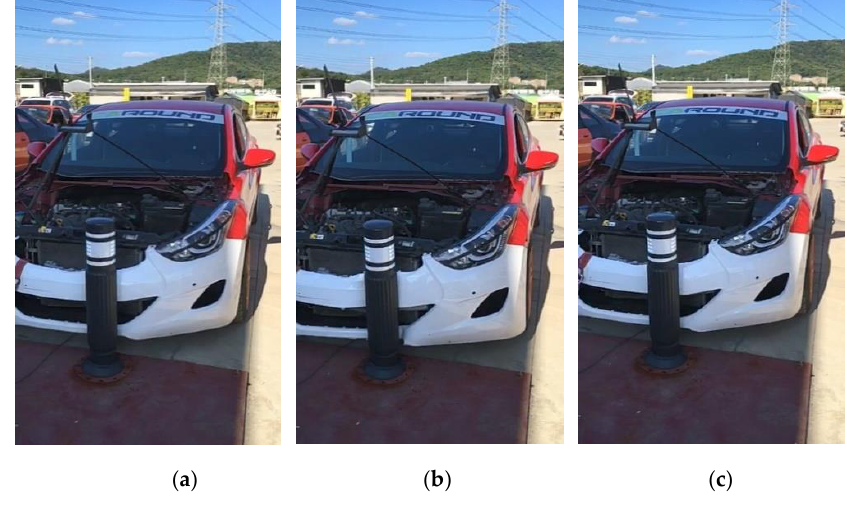
Figure 18. Pictures of an actual collision test with steel bollard: ( a ) the immediate collision; ( b ) maximum deformation; ( c ) falling.